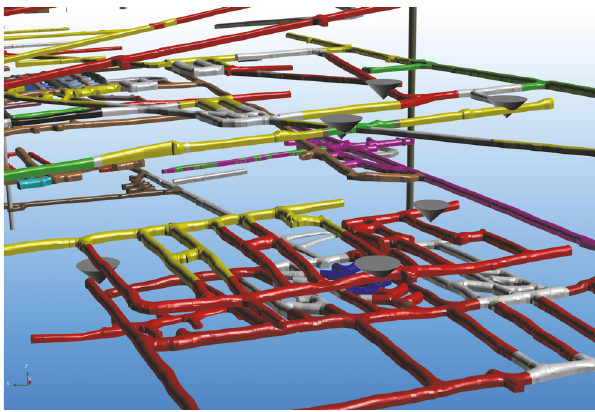
Figure 4: Layout of six accelerators embedded in Dongguashan Copper Mine (a gray inverted cone is used to indicate the accelera-